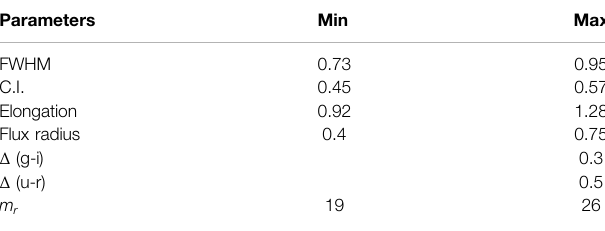
TABLE 5 | Photometric and morphometric parameters adopted for source selections.